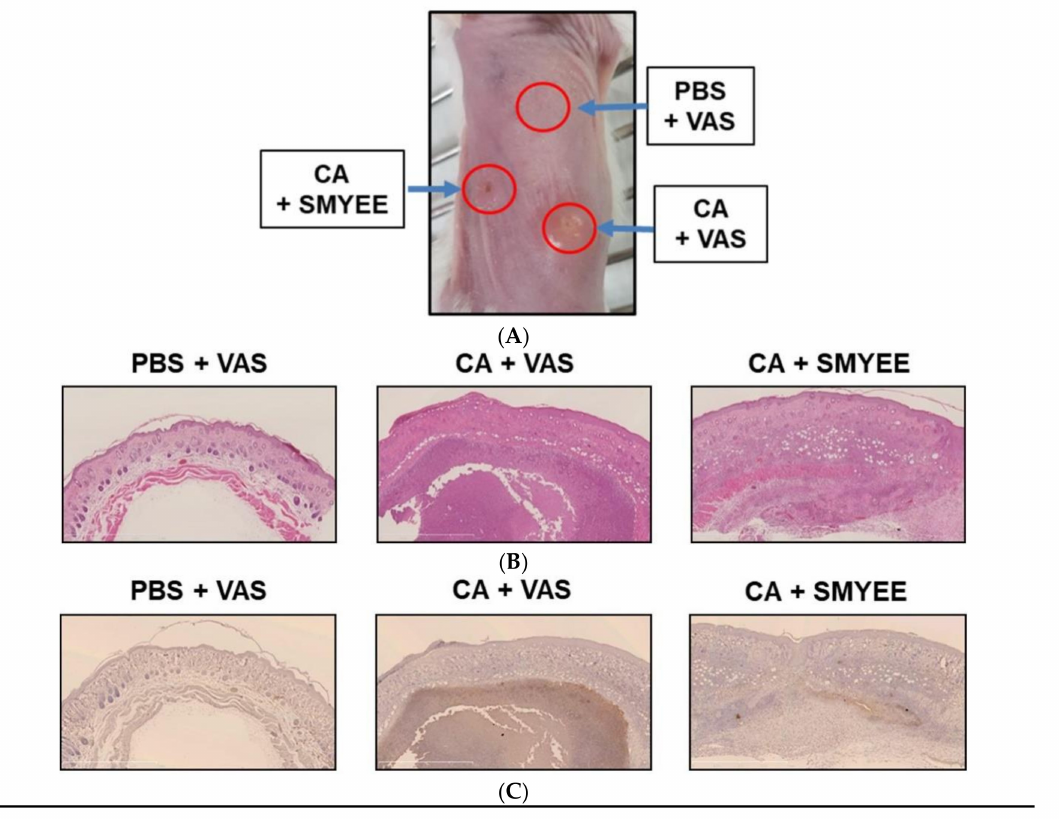
Figure 1. The e ff ects of Sargassum miyabei Yendo ethanolic extract (SMYEE) on inflammation in a model of Cutibacterium acnes ( C. acnes )-induced inflammatory skin disease. The dorsal skin of mice was intradermally injected with 10 µ L (optical density at 600 nm [OD 600 ] = 1.0 mL) of C. acnes . SMYEE (50 µ g mixed with 50 mg Vaseline) was then applied to the skin. ( A ) The inflammatory lesions; ( B ) hematoxylin and eosin staining; ( C ) Neutrophil infiltration of dorsal skin was examined by immunohistochemical staining for NIMP-R14 (a neutrophil marker). CA: C. acnes , VAS: Vaseline, PBS: phosphate-bu ff ered